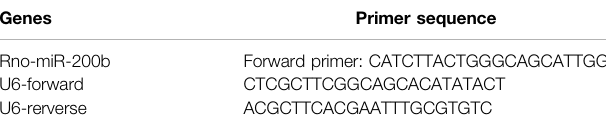
TABLE 2 | Primers sequences used for real-time PCR.